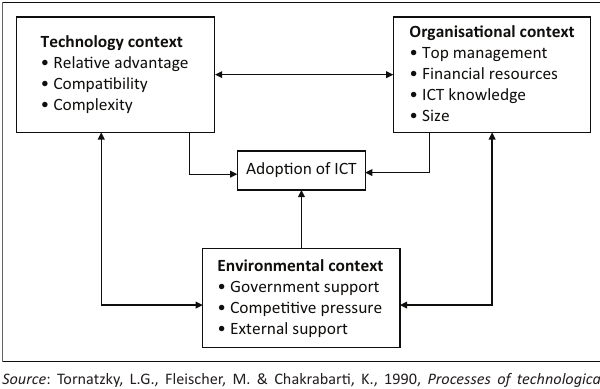
FIGURE 1: Technology, organisation and environment theoretical